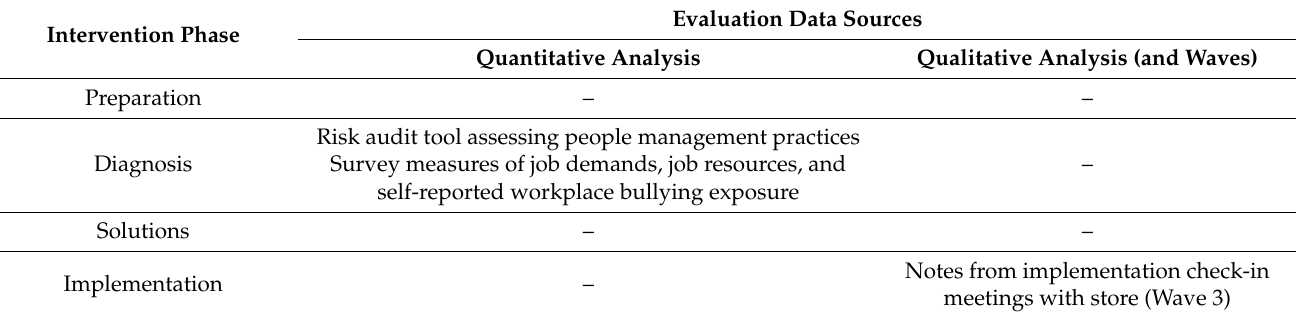
Table 1. Evaluation data sources collected during each phase of the